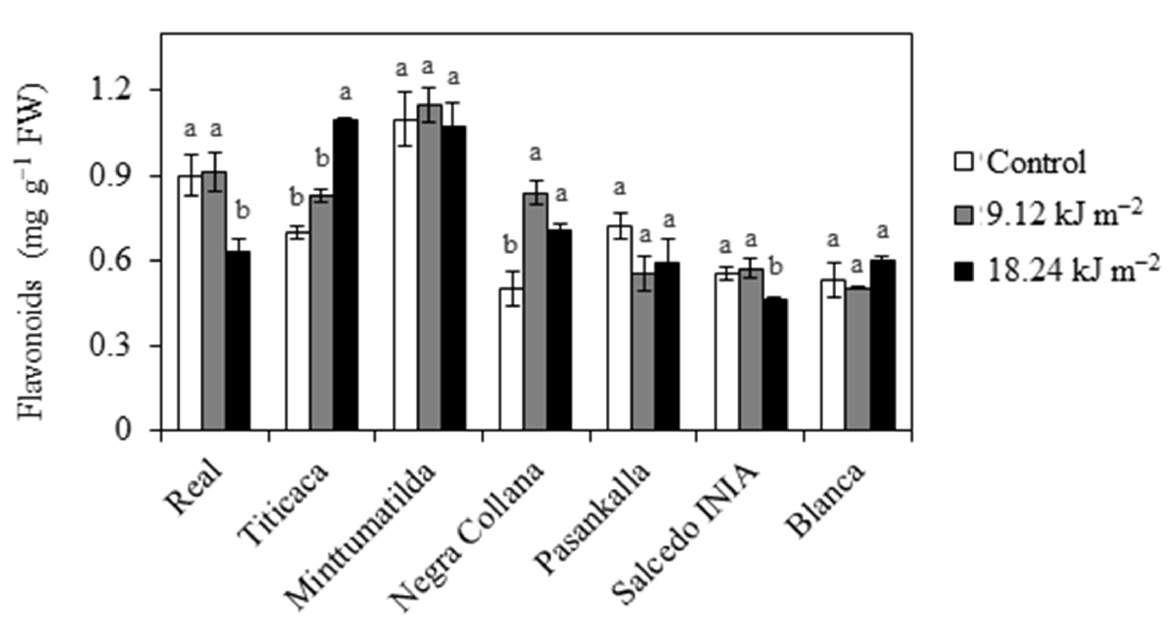
Figure 2. Effects of UV-B on flavonoids concentration. Different quinoa varieties were exposed to 0 (Control), 9.12 and 18.24 kJ m − 2 UV-B. Flavonoids (mg catechin equivalents g − 1 FW) were evaluated in leaves at 3 days of treatment. Error bars represent the standard error of the mean (n = 3). Different letters indicate significant differences between means within the same variety ( P < 0.05, Tukey’s test). FW, fresh weight.